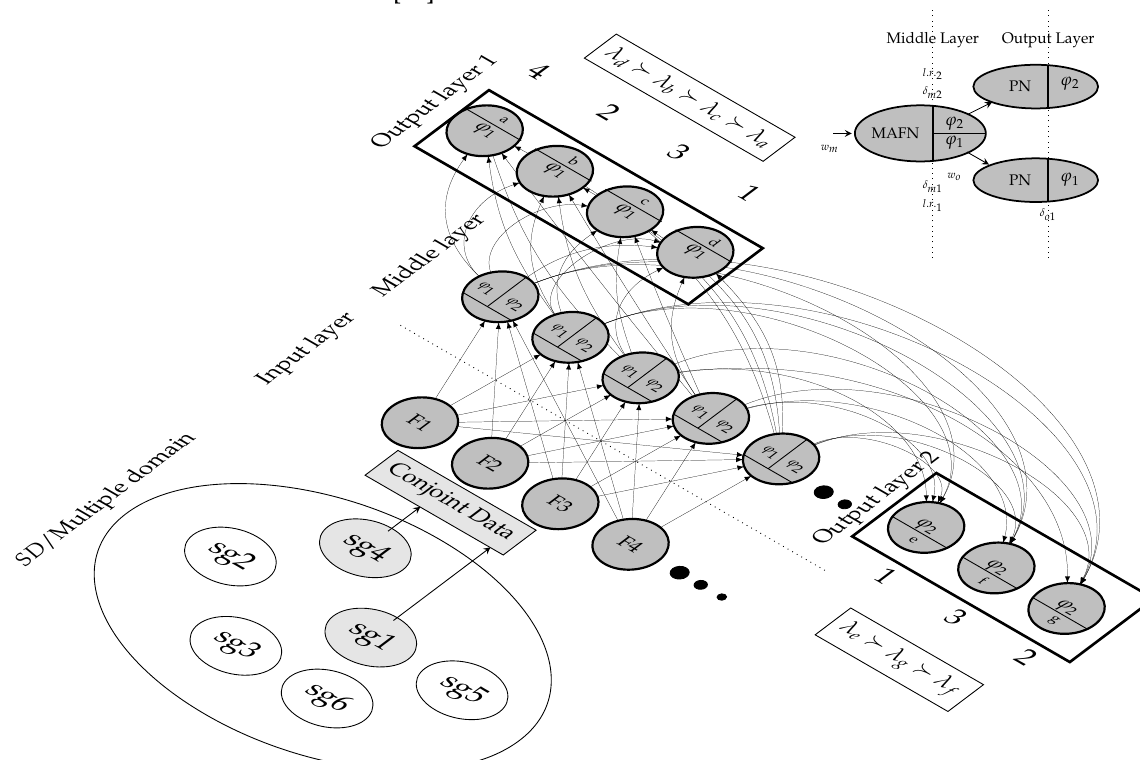
Figure 7. An example of Two subgroups architecture of SGPNN to rank conjoint data from two subgroups data, each group has 4 and 3 labels respectively, where ϕ 1 , ϕ 2 , f in = 4. A video demo of 2-subgroup architecture is available in n = 4 n = 1